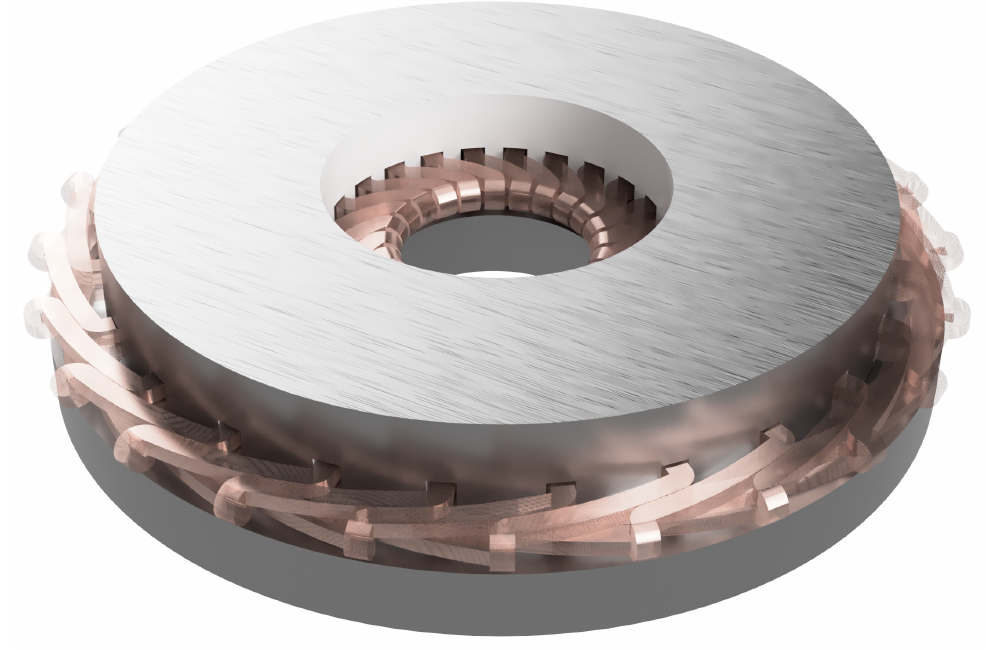
Figure 5. Engine model in